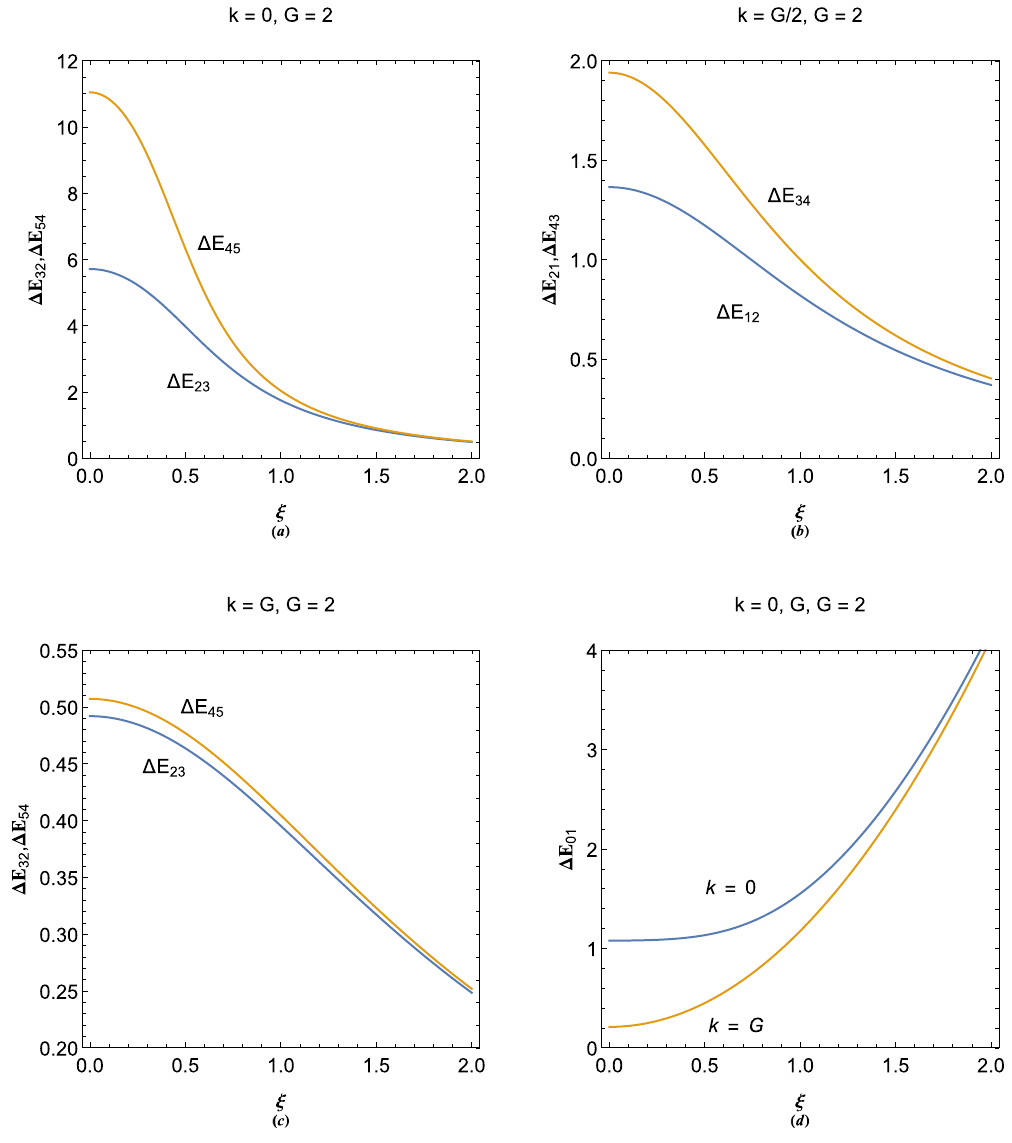
0 with the reciprocal lattice vector size, G 2 . ( b ) = = G / 2 ) with the reciprocal lattice vector = G ) with the reciprocal = 0, G with the reciprocal =